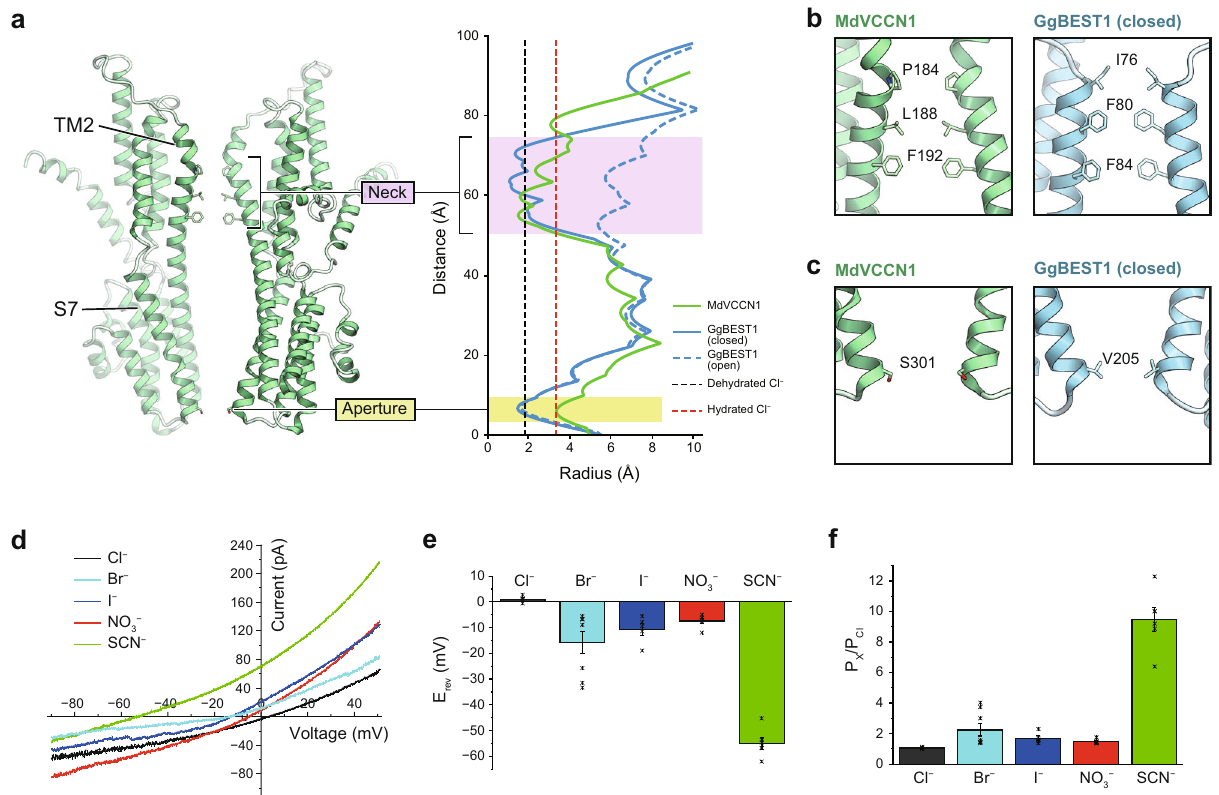
Fig. 4 Ion permeation pathway and anion selectivity of MdVCCN1. a Overview of the ion permeation pathway of MdVCCN1, and pore radii of MdVCCN1 (green) and GgBEST1 (blue: solid line represents closed state (PDB: 6N23) and dashed line represents open state (PDB: 6N28)) along the center axis of the channels. Black and red dashed lines represent the radii of dehydrated and hydrated Cl − , respectively. b Residues forming the neck of MdVCCN1 (left panel) and the closed GgBEST1 (right panel). c Residues forming the aperture of MdVCCN1 (left panel) and the closed GgBEST1 (right panel). d , e Representative traces of whole-cell current-voltage relationships ( d ) and reversal potentials ( e ) for the presence of NaCl ( n = 4), NaBr ( n = 8), NaI ( n = 5), NaNO 3 ( n = 6), or NaSCN ( n = 6) in the bath solution. In e error bars represent s.e.m. Source data are provided as a Source Data fi le. f Comparisons of the permeabilities of Br − ( n = 8), I − ( n = 5), NO 3 − ( n = 6) and SCN − ( n = 6) to Cl − ( n = 4). Error bars represent s.e.m. Source data are provided as a Source Data fi